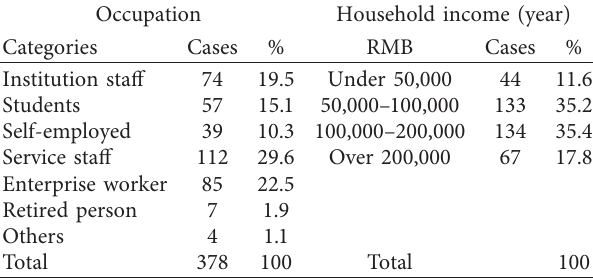
Table 3: Estimated results (Mode